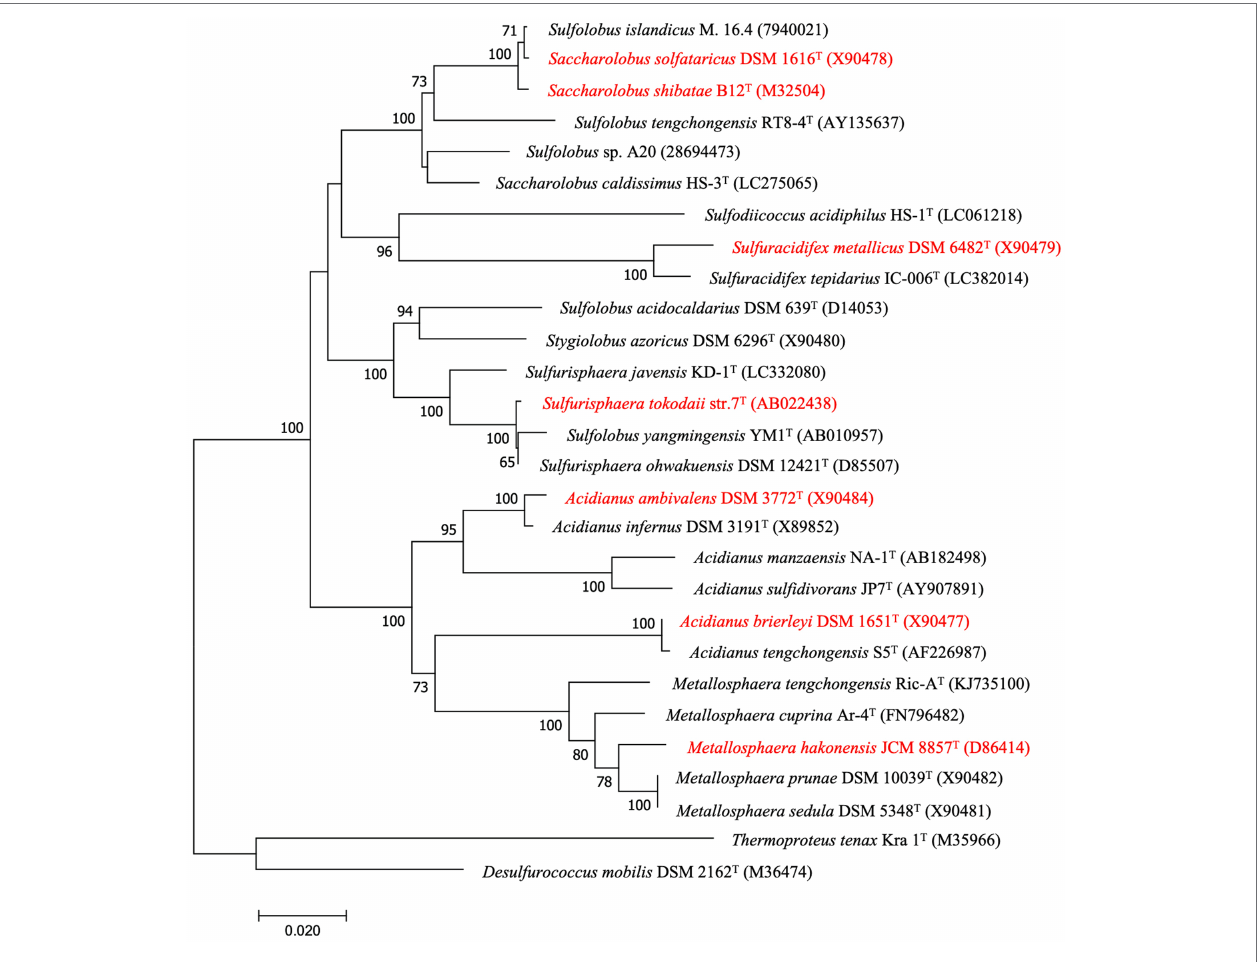
FIGURE 2 | Neighbor-joining phylogenetic tree of the members of Sulfolobales described in this manuscript based on 16S rRNA gene sequences by Mega 7. Numbers at branch nodes represent confidence levels based on 1,000 replicates bootstrap samplings (values greater than 50% are shown), Bar, 0.02 substitutions per nucleotide position. GenBank accession numbers are given in parentheses. The reclassified species are highlighted in